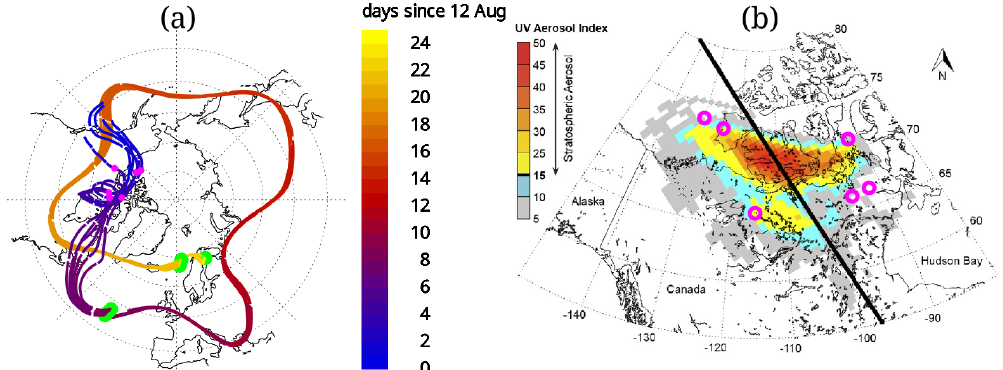
Figure 3. (a) Shows the computed trajectories. The three green areas show the location of the initialization and the two locations where the back trajectories are corrected, mainly in altitude, using a CALIOP match. The latter two correspond to the panels (a) and (b) as well as (c) and (d) in Fig. 2. The colour gradient shows days elapsed since 12 August. The pink circles in the figure on the left are showing the same location as in the figure on the right, (b) . On the right, (b) a reprint of the figure from Peterson et al. (2018, Fig. 3) showing the ultraviolet aerosol index from the Ozone Mapping Profile Suite (OMPS) on 14 August with the CALIPSO satellite track in black. Here the results of the back trajectory on 14 August are added to the figure (pink circles), coinciding with the stratospheric smoke plume. The original figure